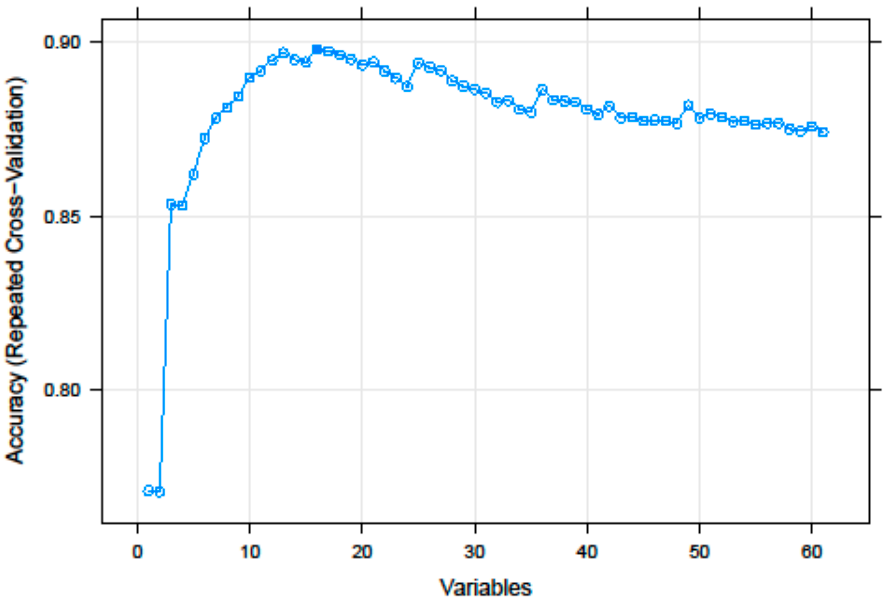
Figure 1. Results of the recursive feature elimination incorporating 1 to all investigated features. An RF analysis was conducted to predict the probiotic/non-probiotic status. The number of features included in the model and the accuracy of prediction are shown on the x-axis and on the y-axis, respectively.